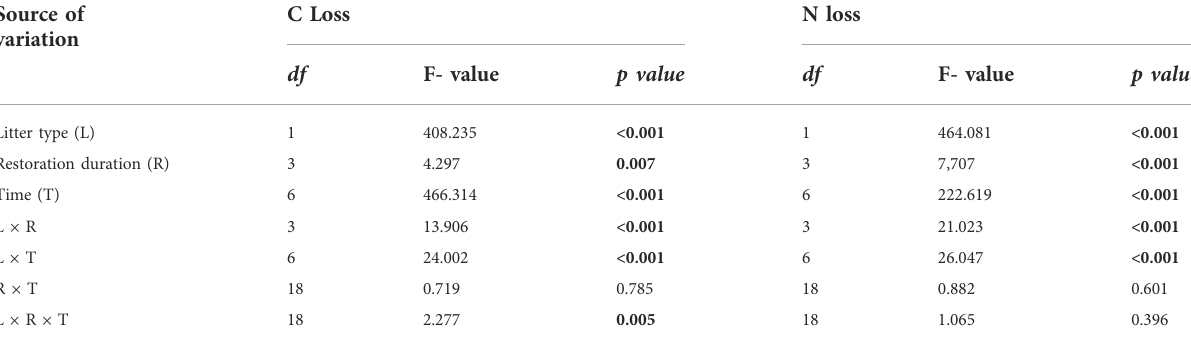
TABLE 2 Signi fi cance of the effects of litter type (L), restoration duration (R), decomposition time (T) and their interactions on litter C and N losses based on multiway ANOVA. Source of variation